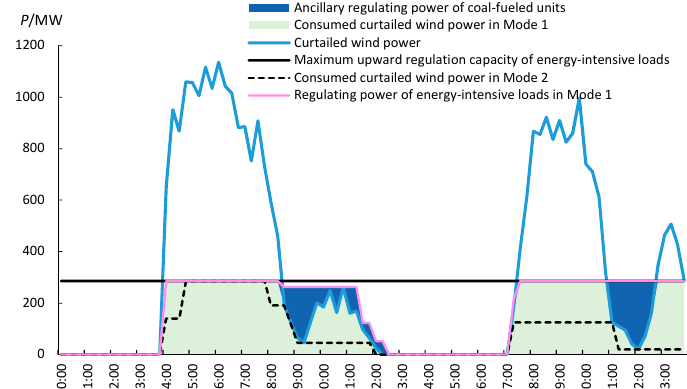
Figure 8. Consumptions of curtailed wind power in different modes. Table 3. Comparison of control results in different modes.